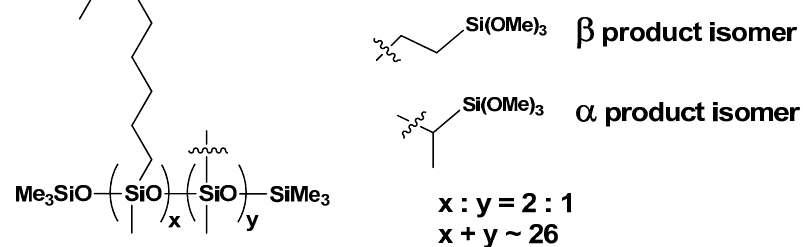
Figure 2. Structure of poly((methyloctylsiloxane)-co-(methyl(trimethoxyethyl)siloxane)), trimethylsilyl terminated.